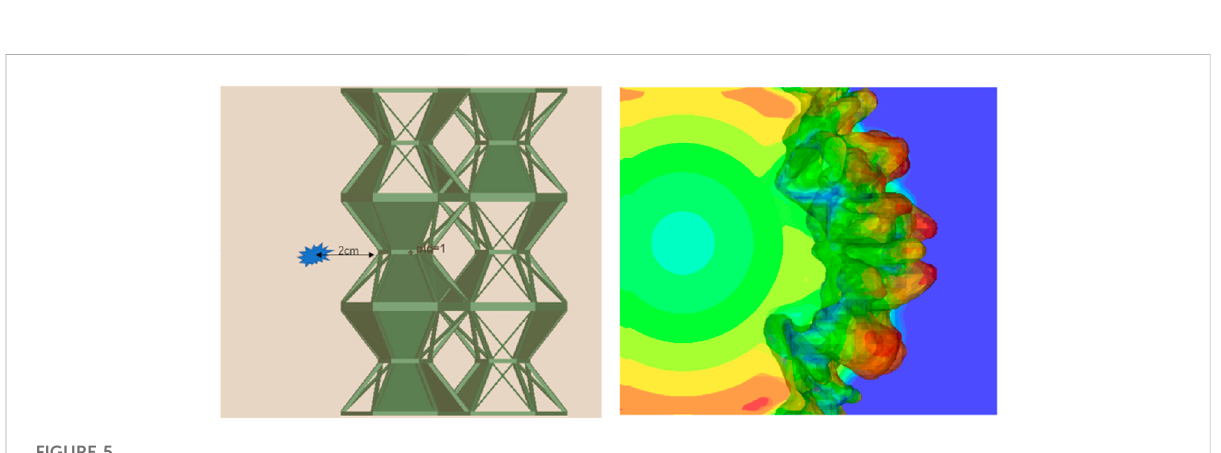
FIGURE 5 Boundary setup and explosion spreading